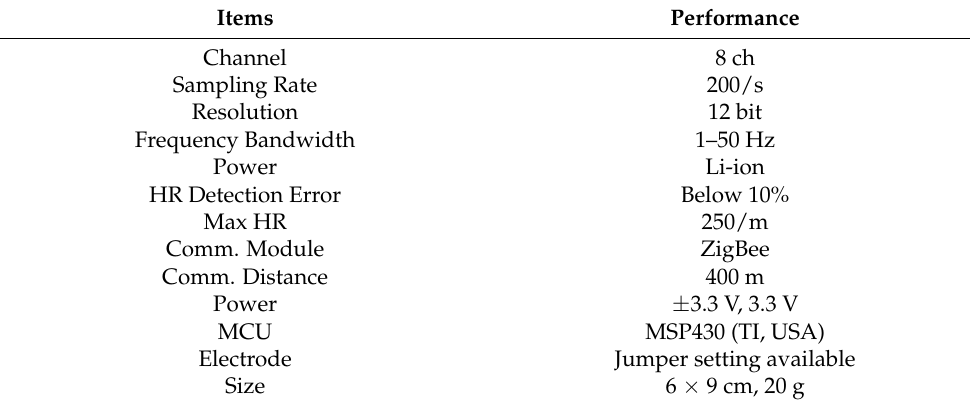
Table 2. Specifications of the AirBeat